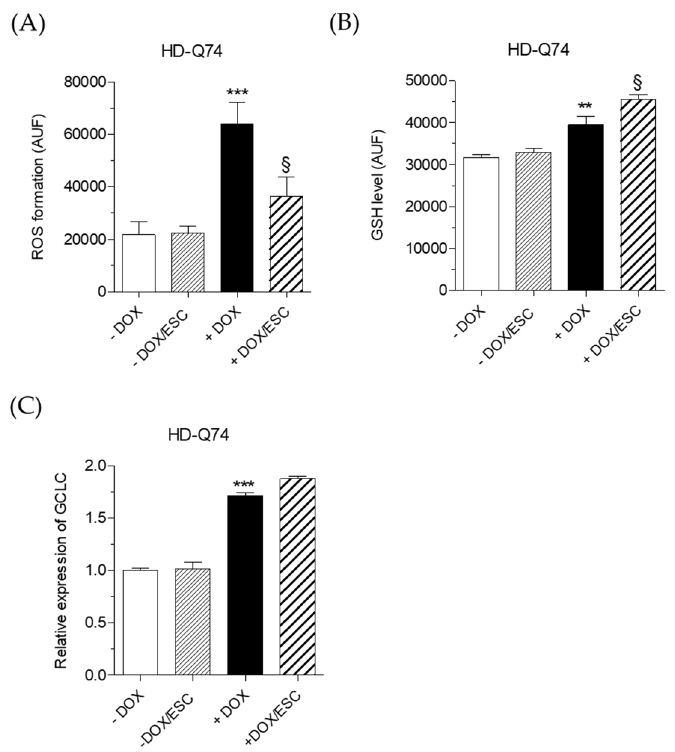
Figure 7. ESC improves the cellular redox status altered by mHTT in HD-Q74 cells. HD-Q74 cells were incubated with DOX (1 µg/mL) for 3 days and ESC (5 µM) was added during the last 24 h of incubation with DOX. ROS formation ( A ) and intracellular GSH levels ( B ) were evaluated using the fluorescent probes H 2 DCF-DA and MCB, respectively, as described in the Materials and Methods; ( C ) GCLC gene expression was evaluated by RT–PCR. Data are reported as the mean ± SEM of at least three independent experiments (** p < 0.01 and *** p < 0.001 vs. HD-Q74 ( − DOX), § p < 0.05 vs. HD-Q74 (+DOX) at one-way ANOVA with Bonferroni post hoc test).